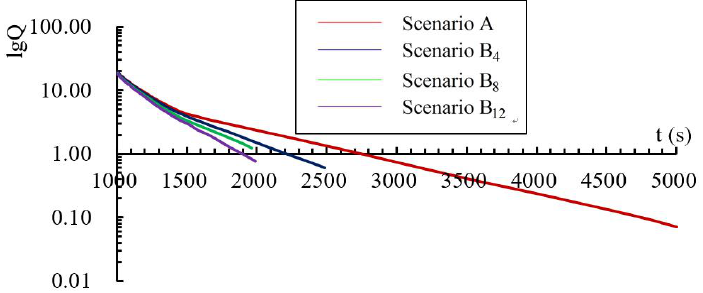
Figure 14. Recession curves of spring hydrographs with different pumping rate at W4.